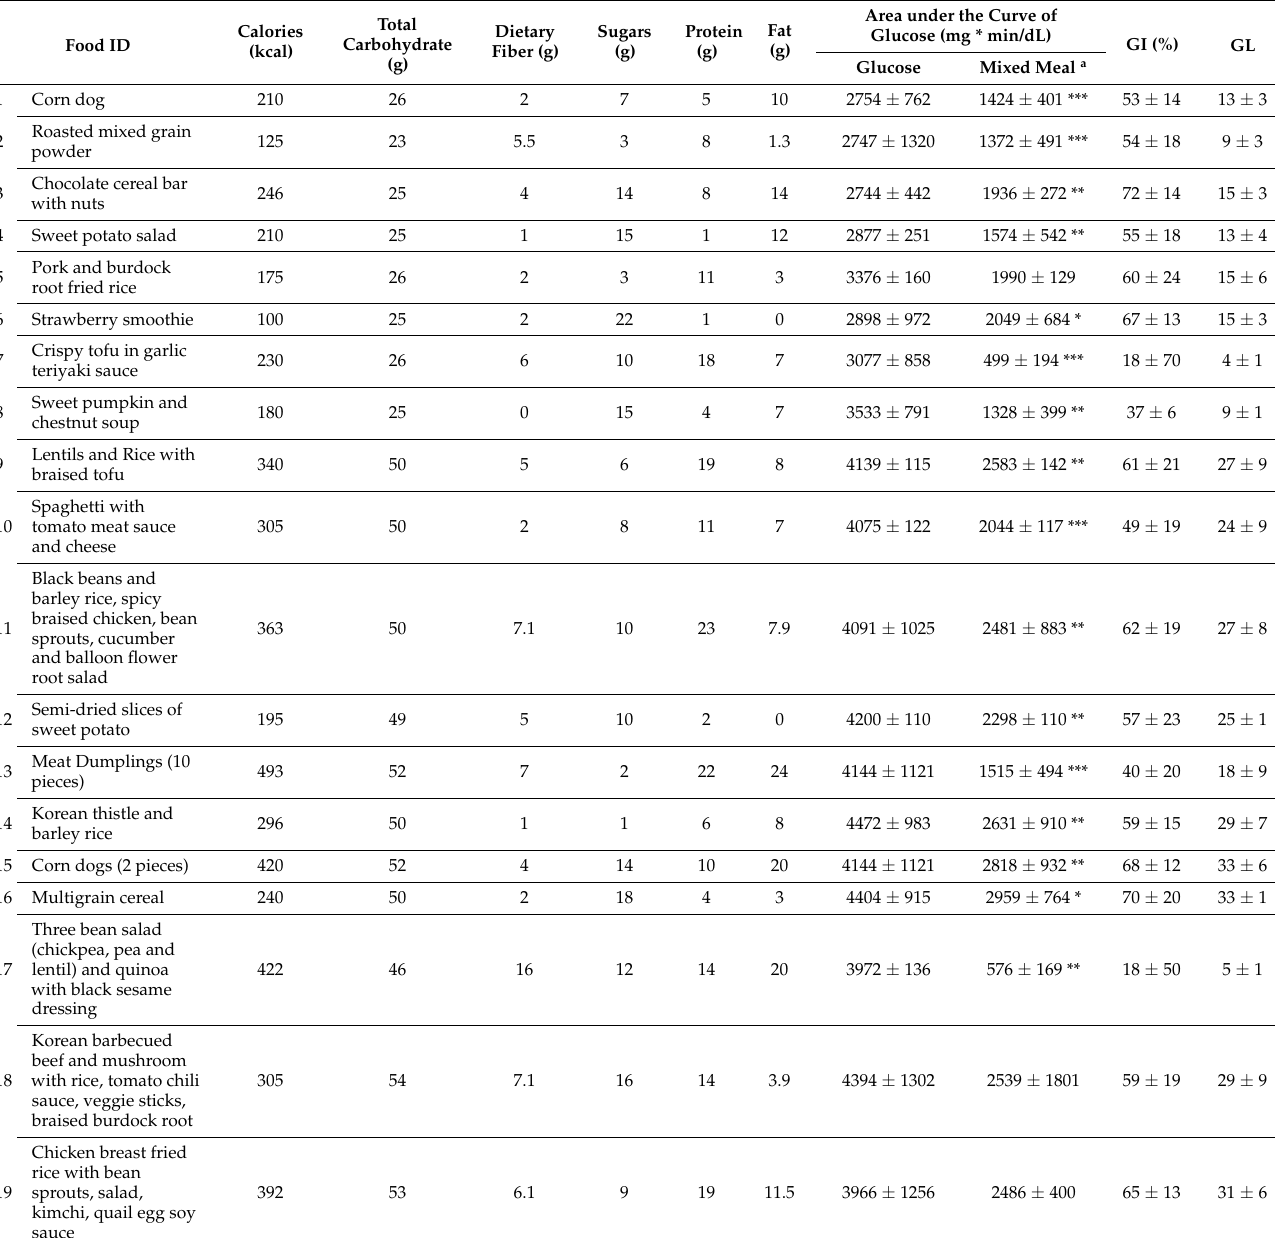
Table 3. Incremental area under the curve (iAUC) of glucose, glycemic index (GI), and glycemic load (GL) after consuming representative mixed meal containing approximately 25 g and 50 g of